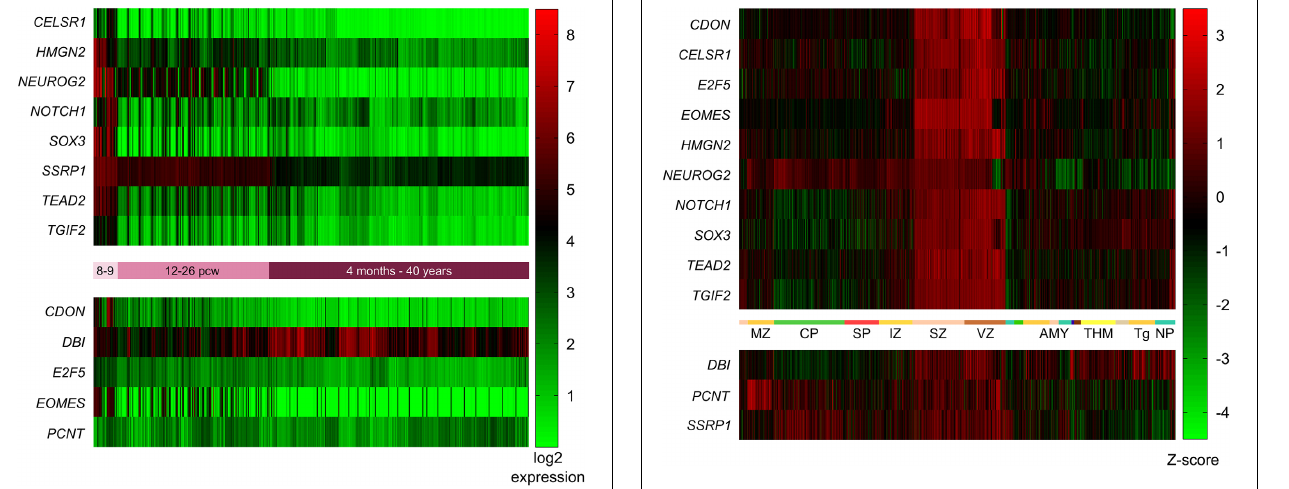
Table 1 . Among the GO enriched terms for biological processes are cell cycle process, mitotic cell process, DNA replication and chromatin assembly and disassembly ( Figure 5B and Table S5).